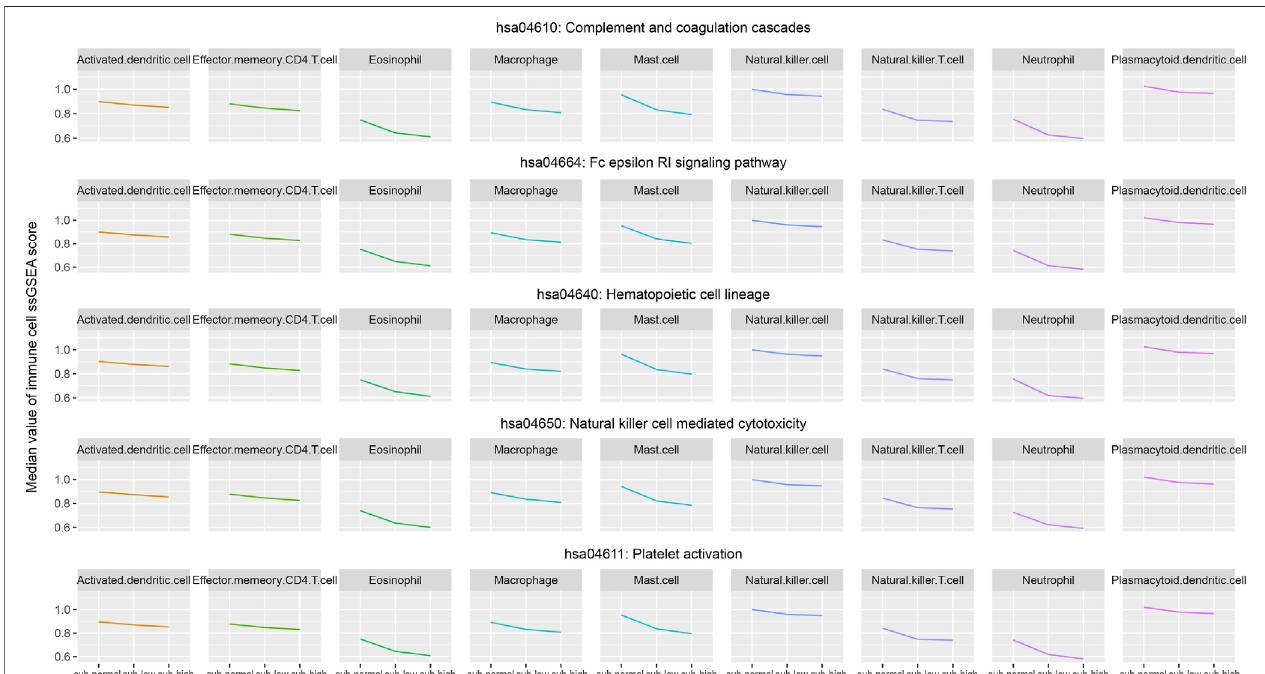
FIGURE 5 | Median values of in fi ltration score of the selected nine immune cells in the three groups (subnormal, sub-low-heterogeneous, and sub-high- heterogenous tumor samples) were evaluated by the ssGSEA algorithm.